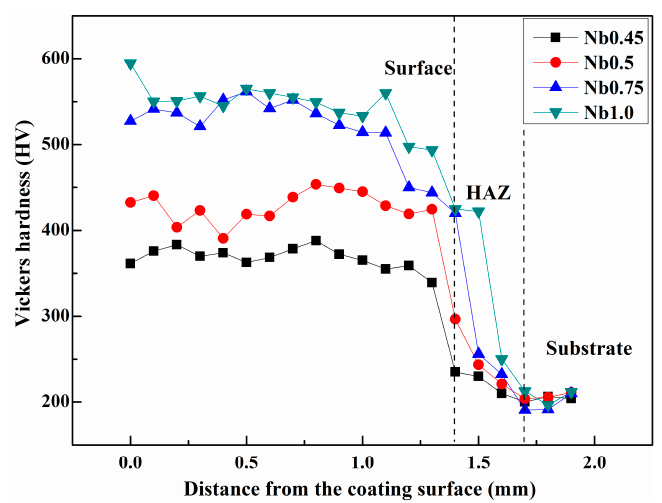
Figure 4. Micro ‐ hardness from surface to substrate of all samples. Figure 4. Micro-hardness from surface to substrate of all samples.